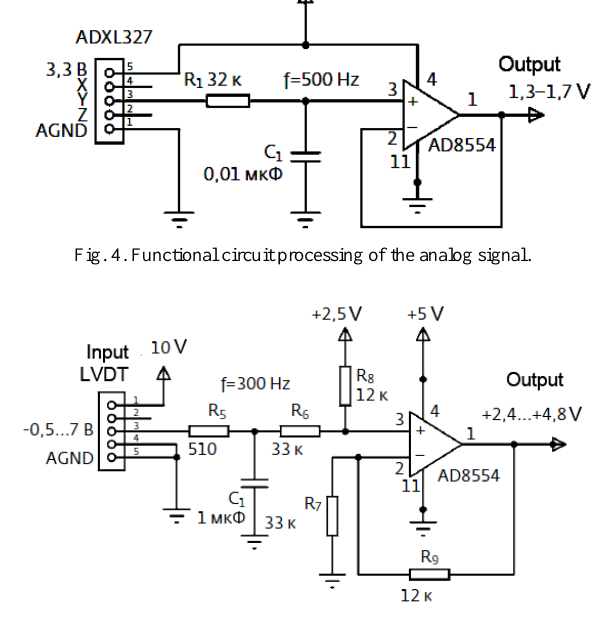
Fig. 5. Functional circuit of analog signal level shifting.